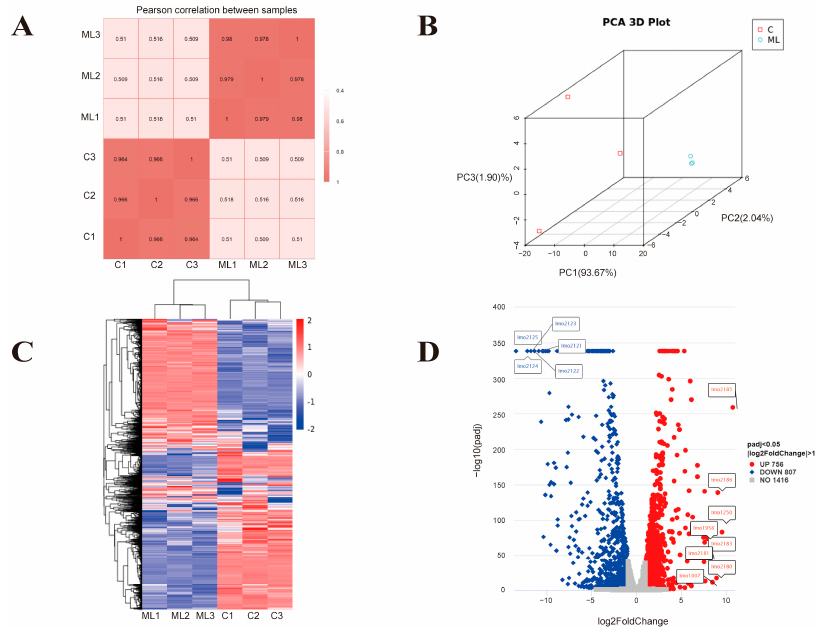
Figure 1. Gene expression patterns of control and ML. ( A ) Gene expression correlation graph. ( B ) Principal component analysis (PCA) graph of gene expression. ( C ) Heat map of DEGs (|log2FC| > 1 and Padj < 0.05). ( D ) Volcano plot of the DEGs (|log2FC| > 1 and Padj < 0.05). Each dot represents a gene, and the up-regulated and down-regulated genes with the largest fold change are marked in the graph. Fold change is represented on the x-axis, while p adjust is represented on the y-axis. Red and blue indicate differentially up-regulated and differentially down-regulated genes, respectively, while gray dots indicate genes that were not significantly different from the control group.